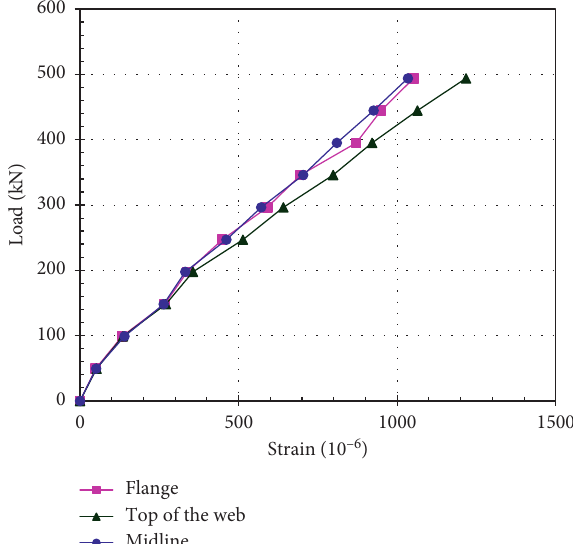
Figure 24: PLG-1 strain of midspan reinforcement after 1 million dynamic